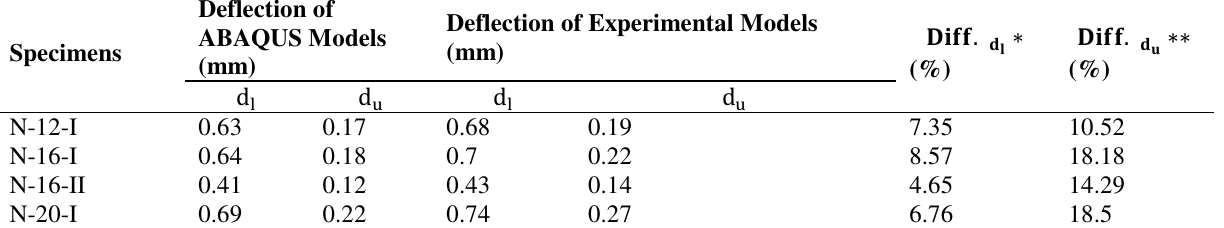
The comparison Between the Results of the Ultimate Deflection of Experimental and Numerical Models of Loaded Side (d l ) and Unloaded Side (d u